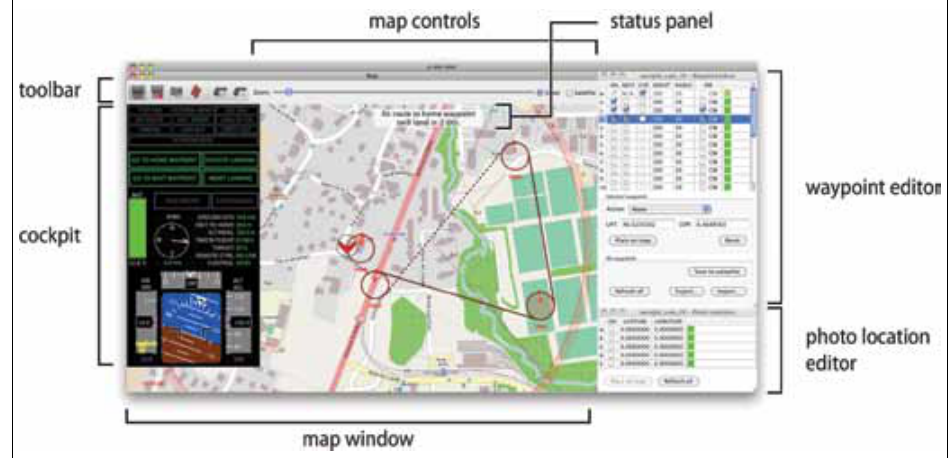
Fig. 8: e-mo-tion software panel, showing the map window, the waypoint editor and the photo- graph location editor (© senseFly LLC).